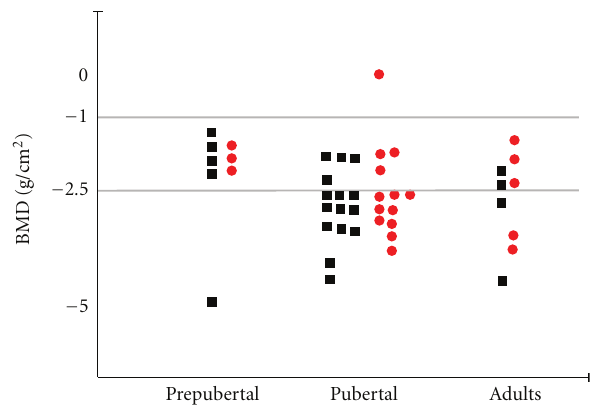
Figure 2: L1–L4 bone mass density ( Z Score) in patients with thalassemia major.